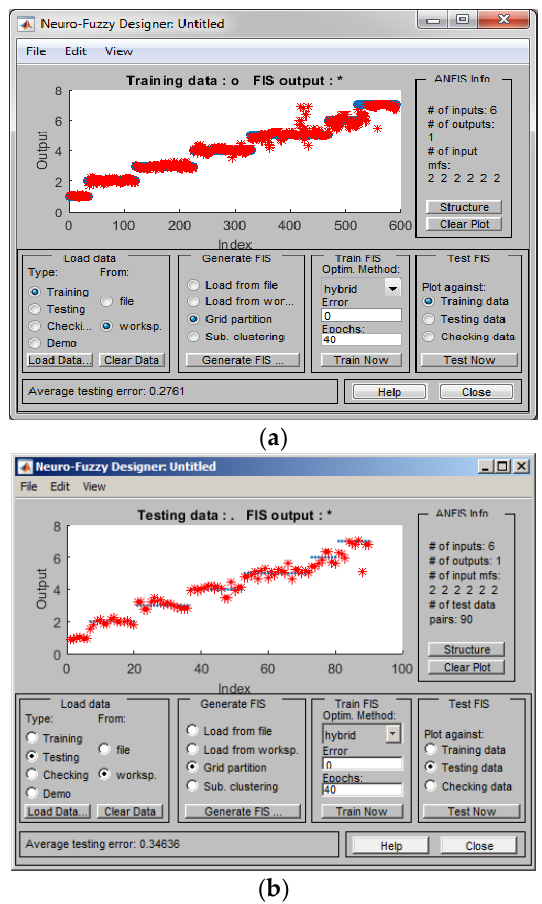
Figure 9. Testing of the ANFIS classifier. ( a ) training data set; ( b ) testing data set.